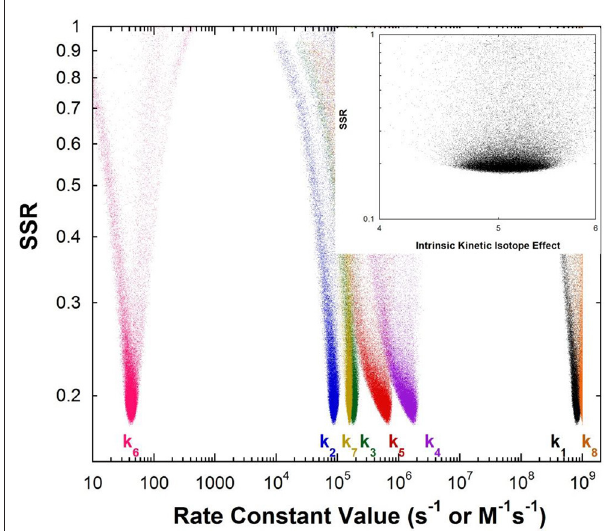
FIGURE 1 | Results of global optimization with KSI. SSR, sum of squared residuals of the fit to the target function. Each point results from an independent optimization run. The figure was generated from ∼ 100,000 independent runs, each starting from randomized sets of rate constants. The inset presents the intrinsic KIE resulting from global